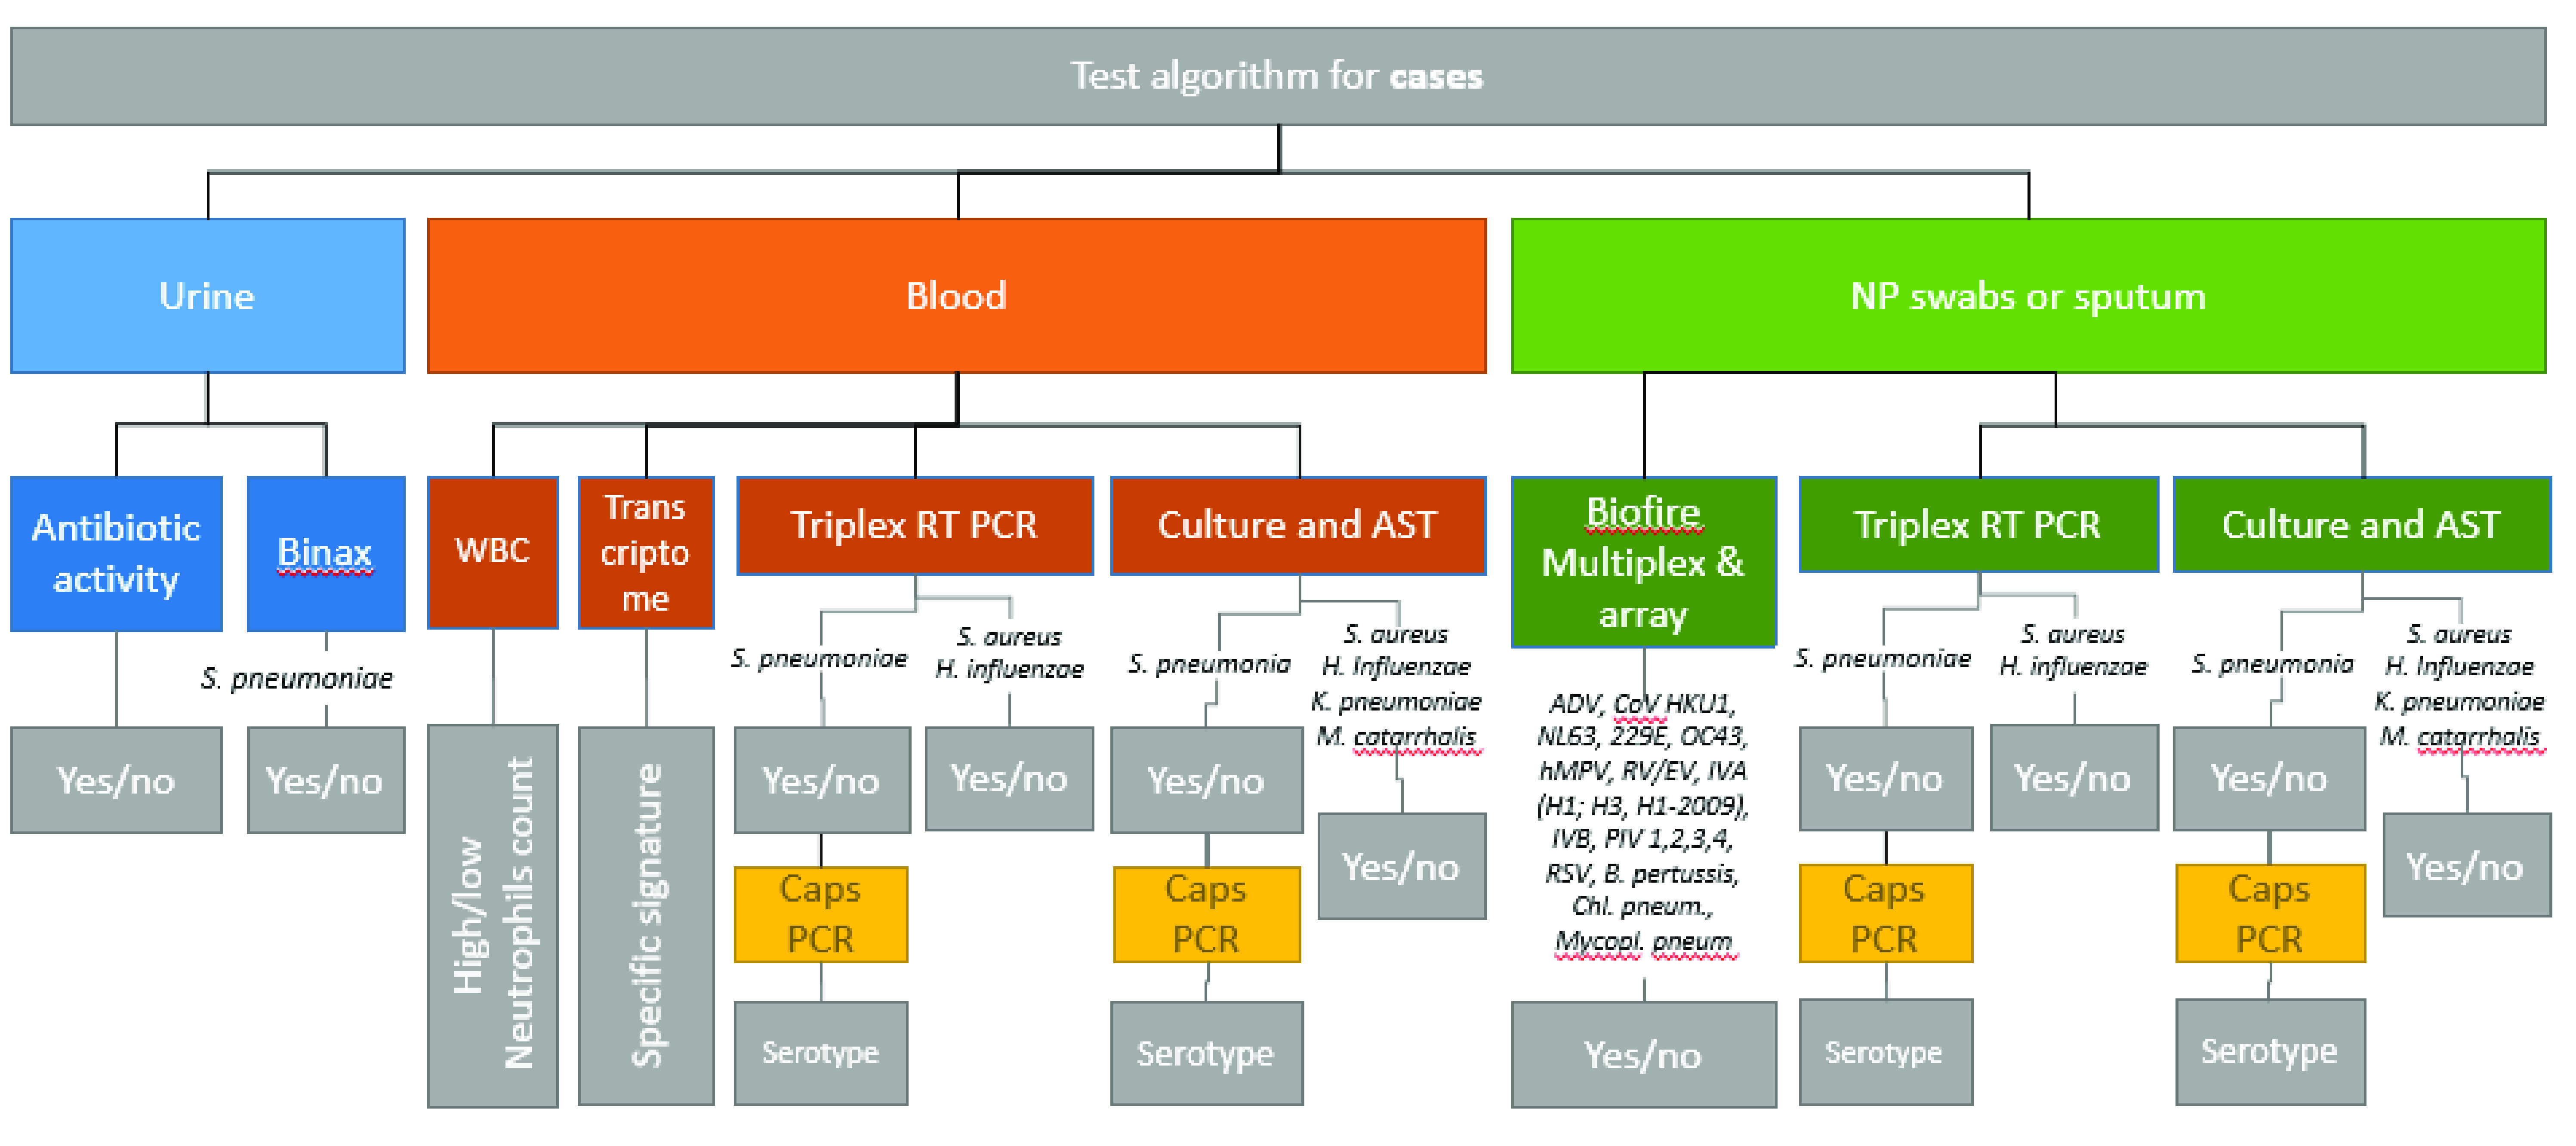
Sample analysis for cases.NP, nasopharyngeal; WBC, white blood cells; AST, Antimicrobial Susceptibility Testing; Caps PCR, capsular antigen serotyping PCR.